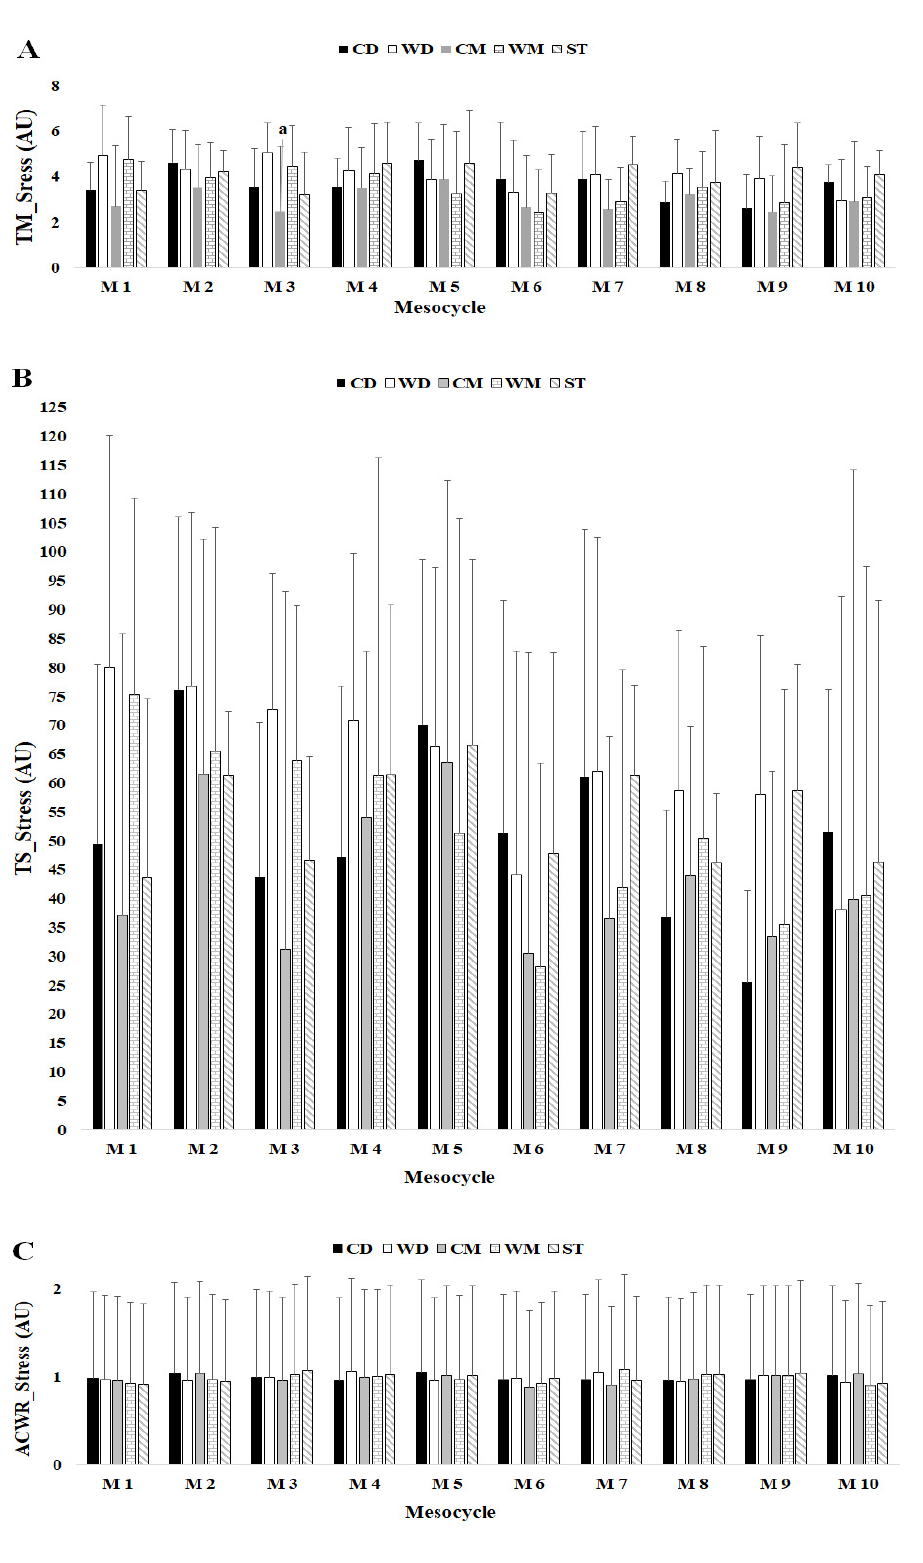
Fig. 4. Training Monotony (TM), Training Strain (TS) and Acute: Chronic Workload Ratio (ACWR) variations calculated through stress category across 10 mesocycles (M1-10) for player positions. (A) TM. (B) TS. (C) ACWR. (a) denote significant difference from WD ( p < 0.05). CD, central defenders; WD, wide defenders; CM, central midfielders; WM, wide midfielders; ST,